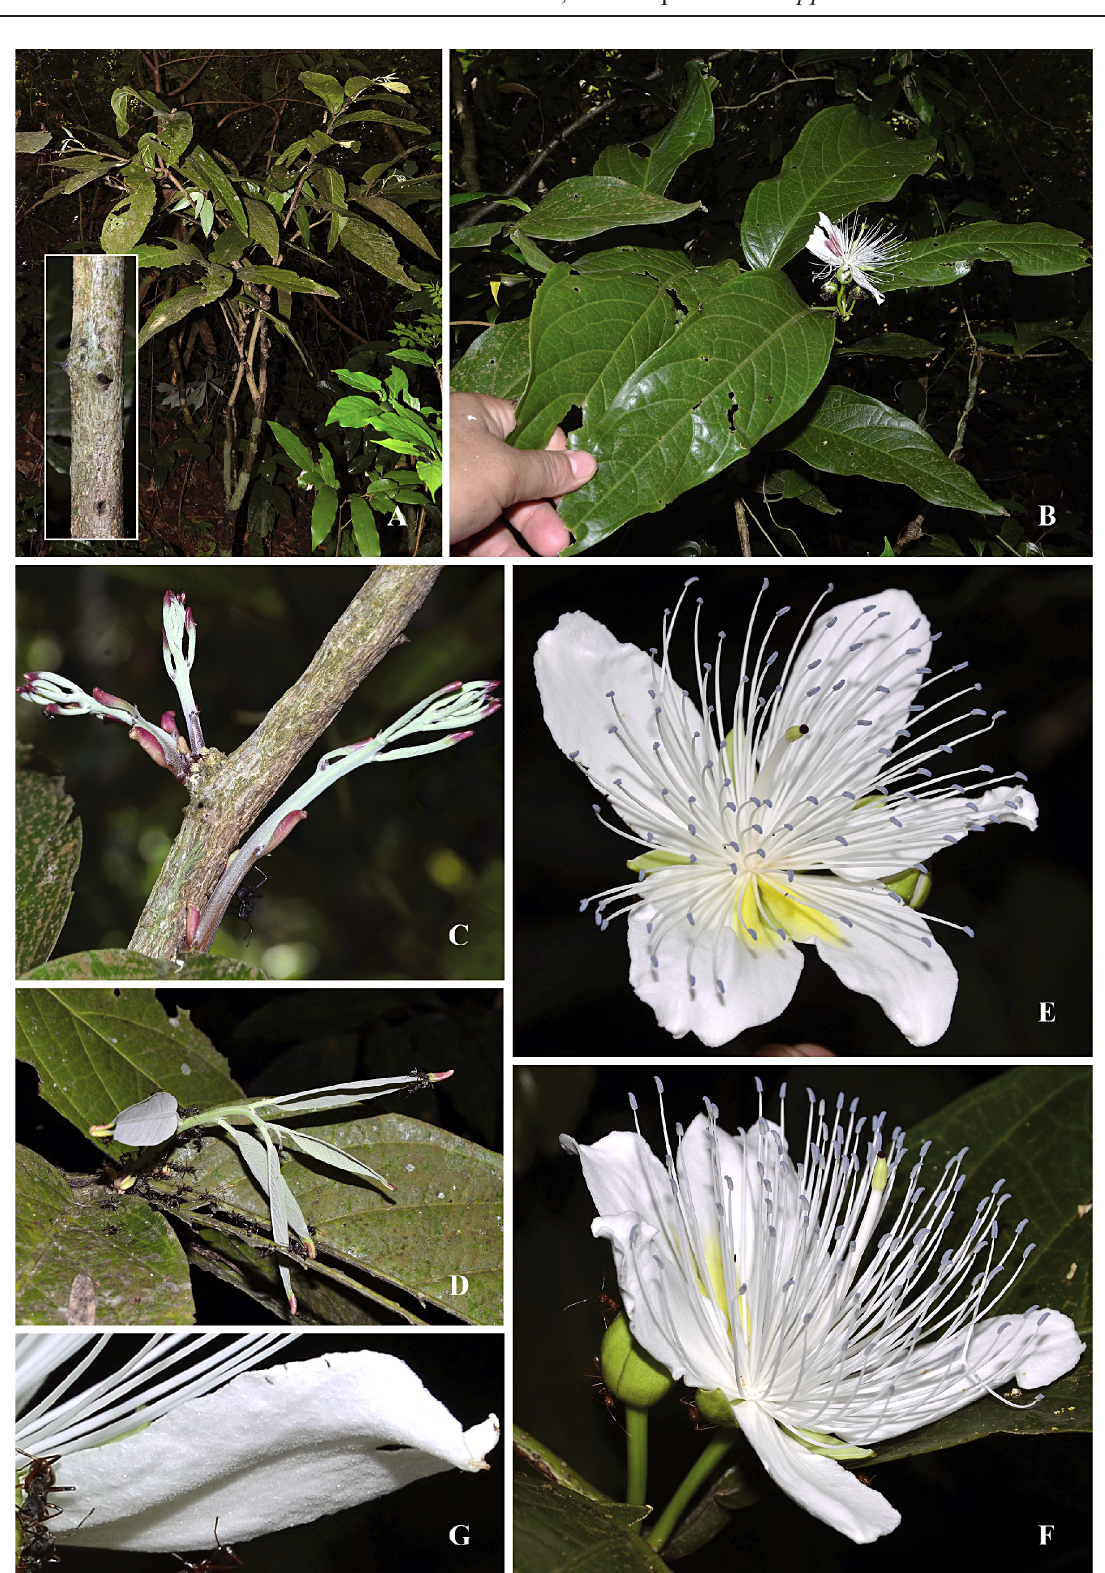
Fig. 2. Capparis macrantha Souvannakhoummane, Fici & Lanorsavanh sp. nov. A . Habit and detail of a branch bearing thorns. B . Flowering branch. C . Young twigs. D . Young leaves. E . Flower (top view). F . Flower (lateral view). G . Petal (outside view). Photos by